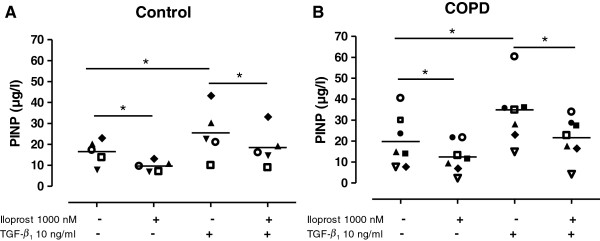
Collagen synthesis is enhanced by TGF-β1 in control and COPD fibroblasts and attenuated by iloprost treatment. Collagen I production was measured as the propeptide of type I procollagen (PINP) in the supernatant from distal lung fibroblasts from control subjects (n = 5; A) and patients with COPD (n = 7; B). Cells were stimulated with iloprost (1000 nM) and TGF-β1 (10 ng/ml) in 0.4% fibroblast medium pretreated with indomethacin (3 μM). Data are presented as median with individual values and median values are represented as a line. *p < 0.05. Statistical analysis is performed with Mann Whitney t-test to compare differences between control and COPD fibroblasts and Wilcoxon paired rank sum test is used to analyze differences within the control and COPD fibroblasts.